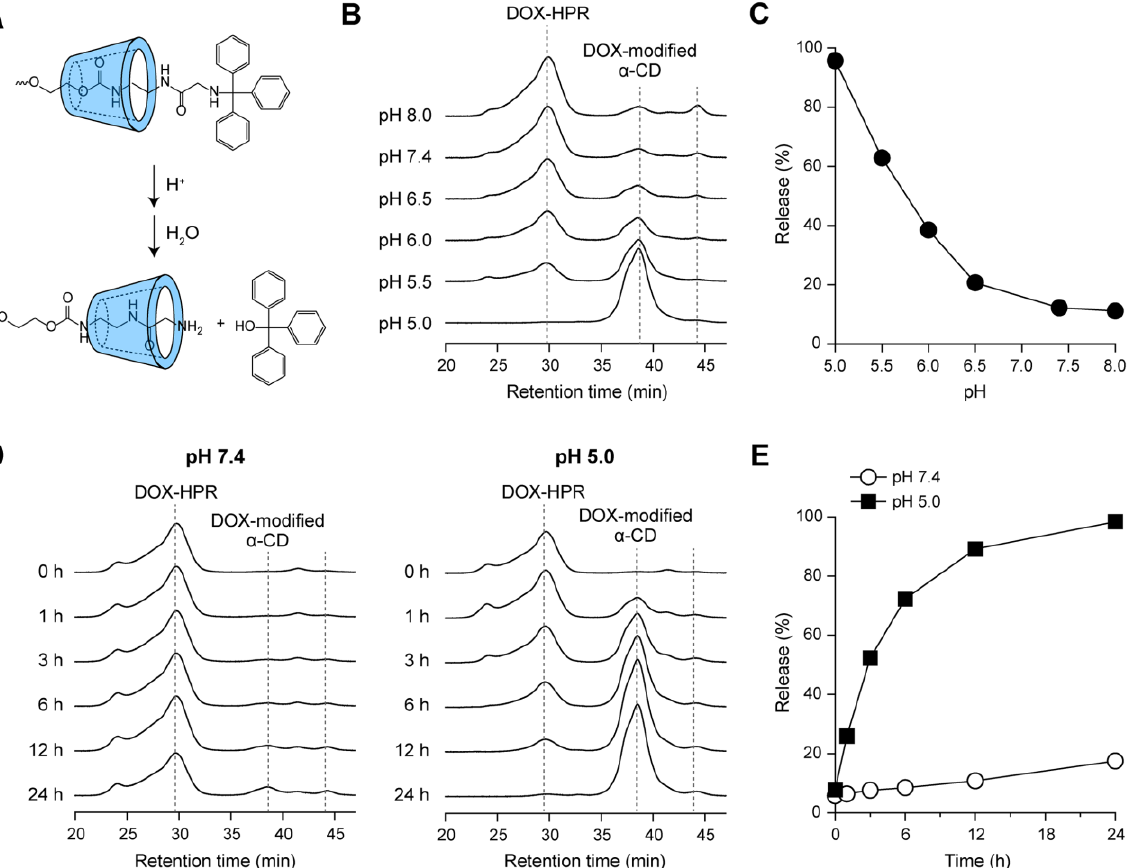
Figure 5. ( A ) Schematic showing the cleavage of N -Trt groups in acid-degradable PRXs under acidic condition. ( B ) SEC charts of DOX-HPR after incubation at pH 5.0–8.0 at 37 °C for 24 h. SEC measurements were performed using DMSO as an eluent and the peaks were detected at 500 nm. ( C ) Relationship between pH and release profiles of DOX-modified α-CDs from DOX-HPR after incubation at 37 °C for 24 h, ( D ) SEC charts of DOX-HPR after incubation at pH 7.4 and 5.0 at 37 °C for 0–24 h. ( E ) Release profiles of DOX-modified α-CDs from DOX-HPR with time after incubation at pH 7.4 and 5.0 at 37 °C.